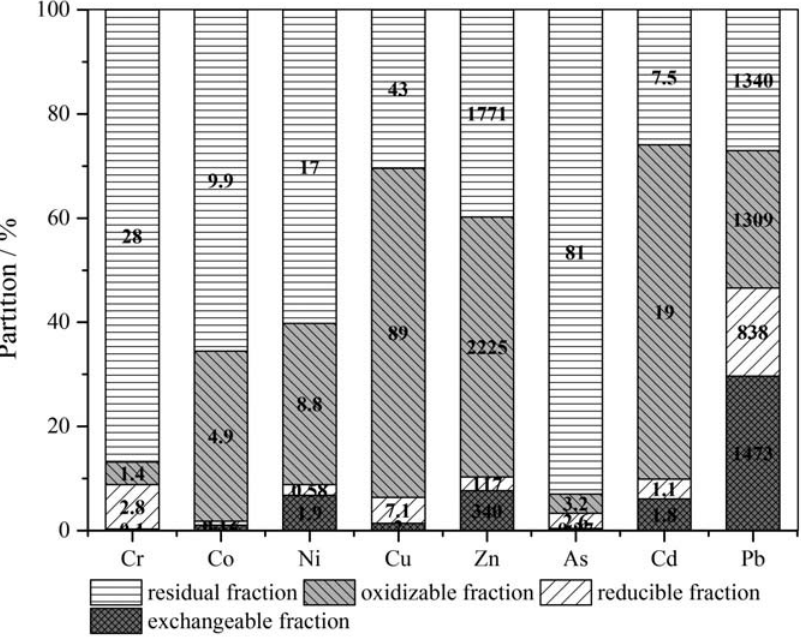
Fig. 1. Partitioning of metals in tailings, determined by modified BCR procedure (with corresponding concentration values in mg of metal per kg of